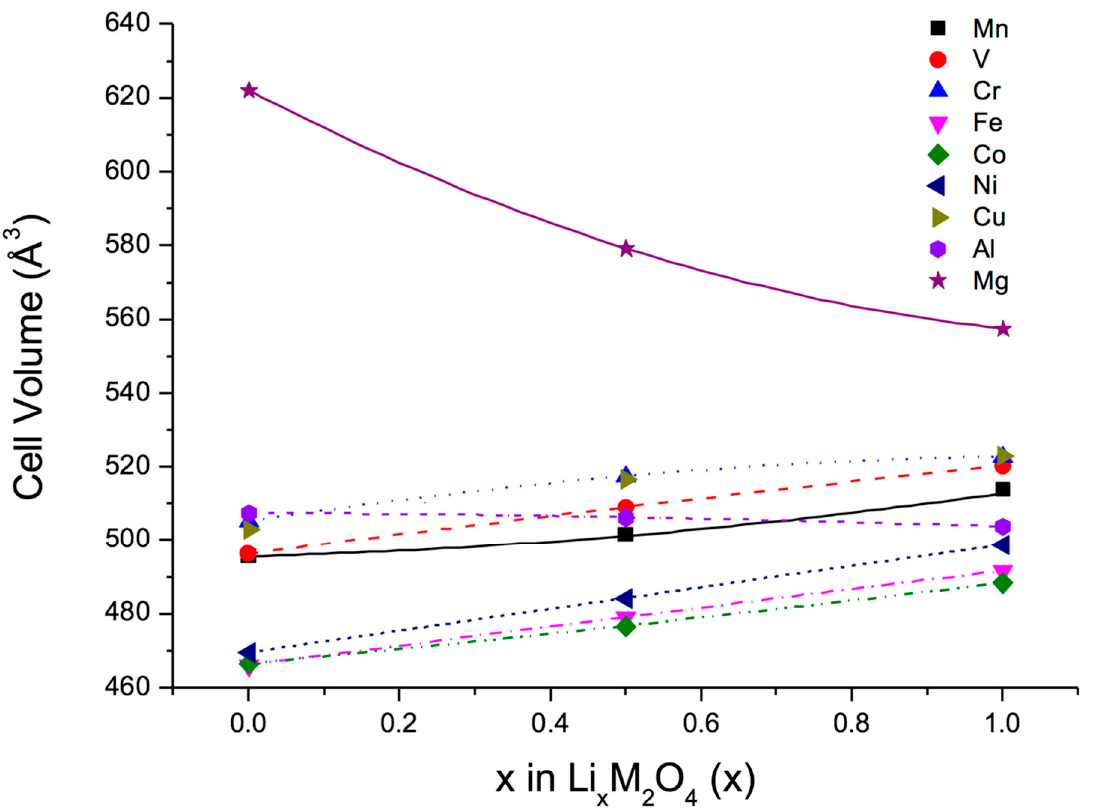
Figure 2. Computed cell volume as a function of Li concentration in transition-metal oxides with the spinel structure.